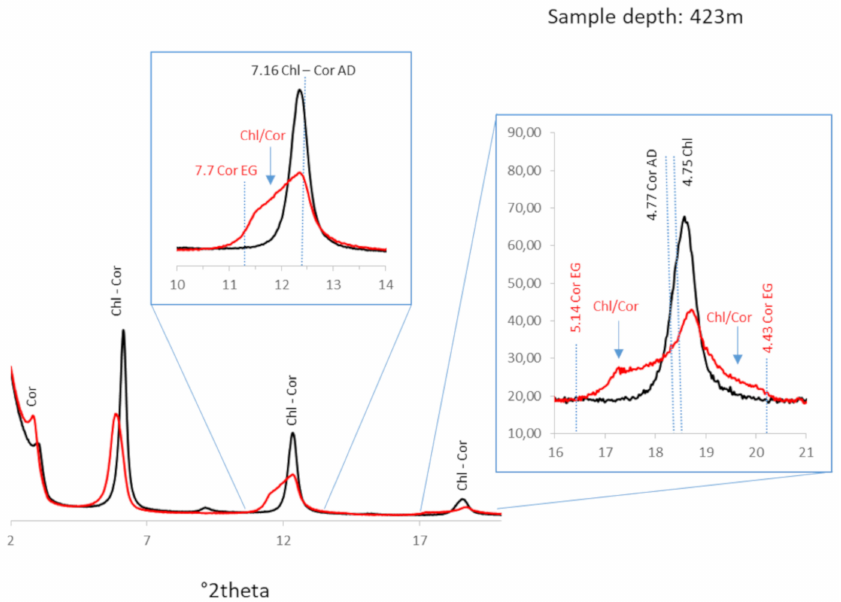
Figure 7. X-ray diffractograms of oriented preparations: infra 2 µ m clay fraction. In black: air dried; in red: ethylene glycol-solvated preparation. Cor: corrensite, Chl: chlorite, and Chl/Cor: